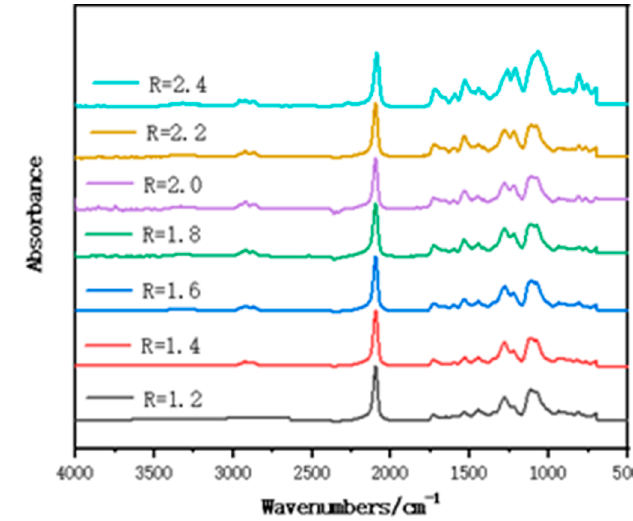
Figure 2. FT − IR spectrum of polymer fi lms with di ff erent R.